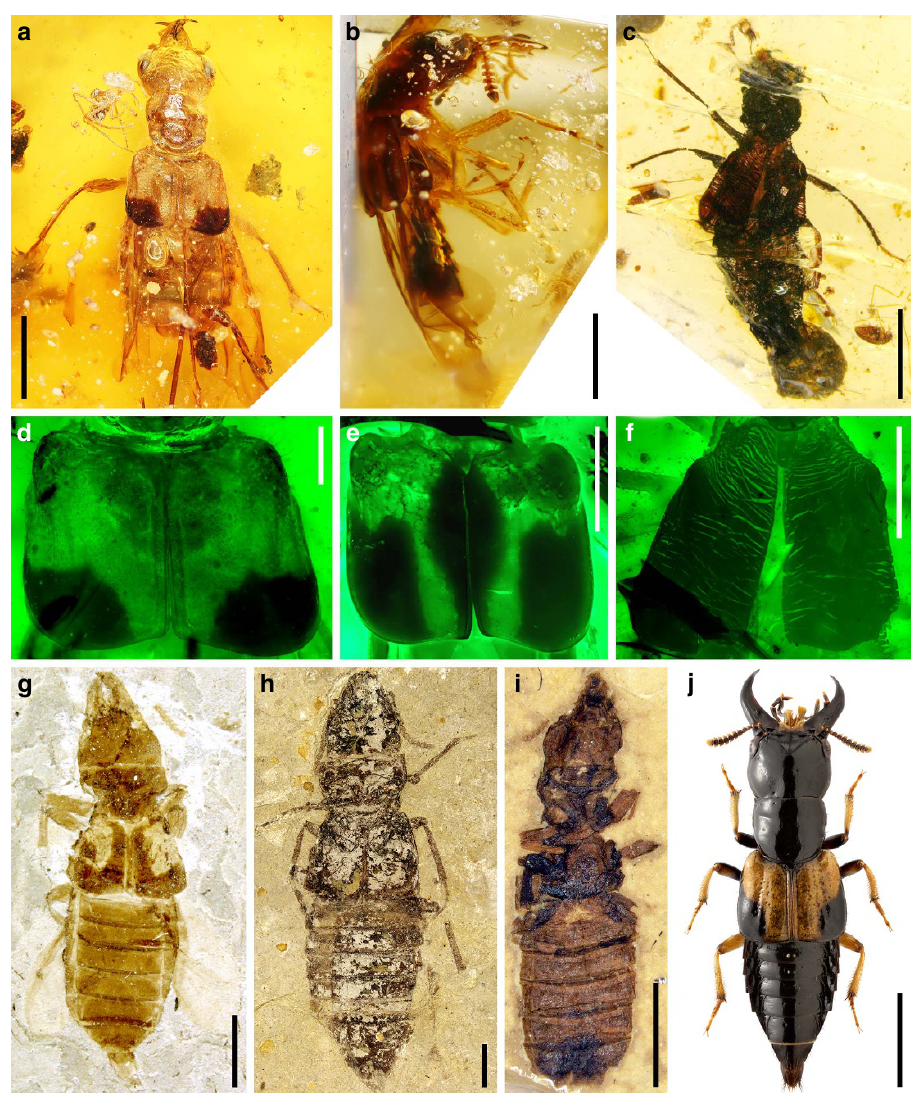
Figure 2 | Diverse mycophagous oxyporine rove beetles. ( a – c ) Beetles from mid-Cretaceous Burmese amber, ( d – f ) under fluorescence, ( g – i ) from the Early Cretaceous Yixian Formation of northeastern China. ( a ) Dorsal view of Taxon 1, NIGP164526. ( b ) Lateral view of Taxon 2, NIGP164528. ( c ) Dorsal view of Taxon 3, NIGP160556. ( d ) Enlargement of elytra from a . ( e ) Enlargement of elytra from b . ( f ) Enlargement of elytra from c . ( g ) Oxyporus yixianus ; image courtesy of Yanli Yue. ( h ) Protoxyporus grandis . ( i ) Cretoxyporus extraneus . ( j ) O. maxillosus ; image courtesy of Maxim Smirnov. Scale bars, 2mm ( a , c and g – j ); 1mm ( b ); 500 m m ( d – f ). NATURE COMMUNICATIONS|8:14894|DOI: